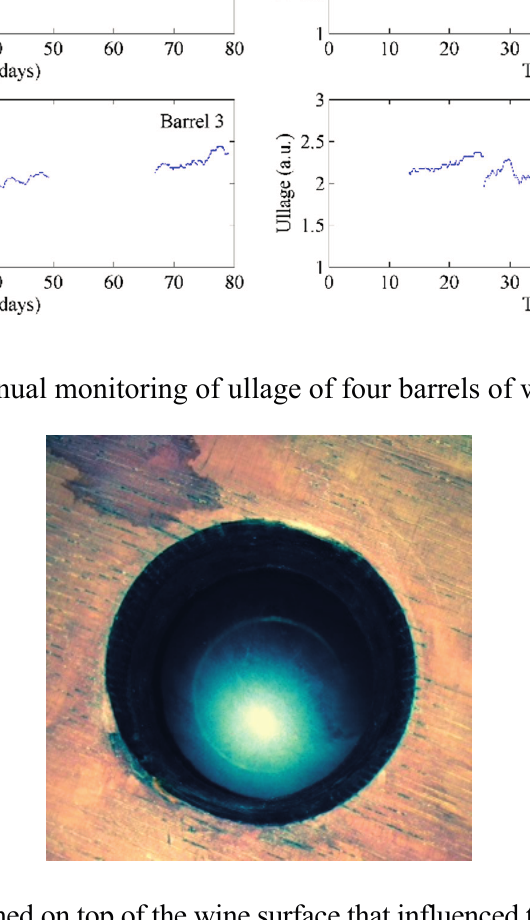
Figure 6. A thin film formed on top of the wine surface that influenced the ullage sensor